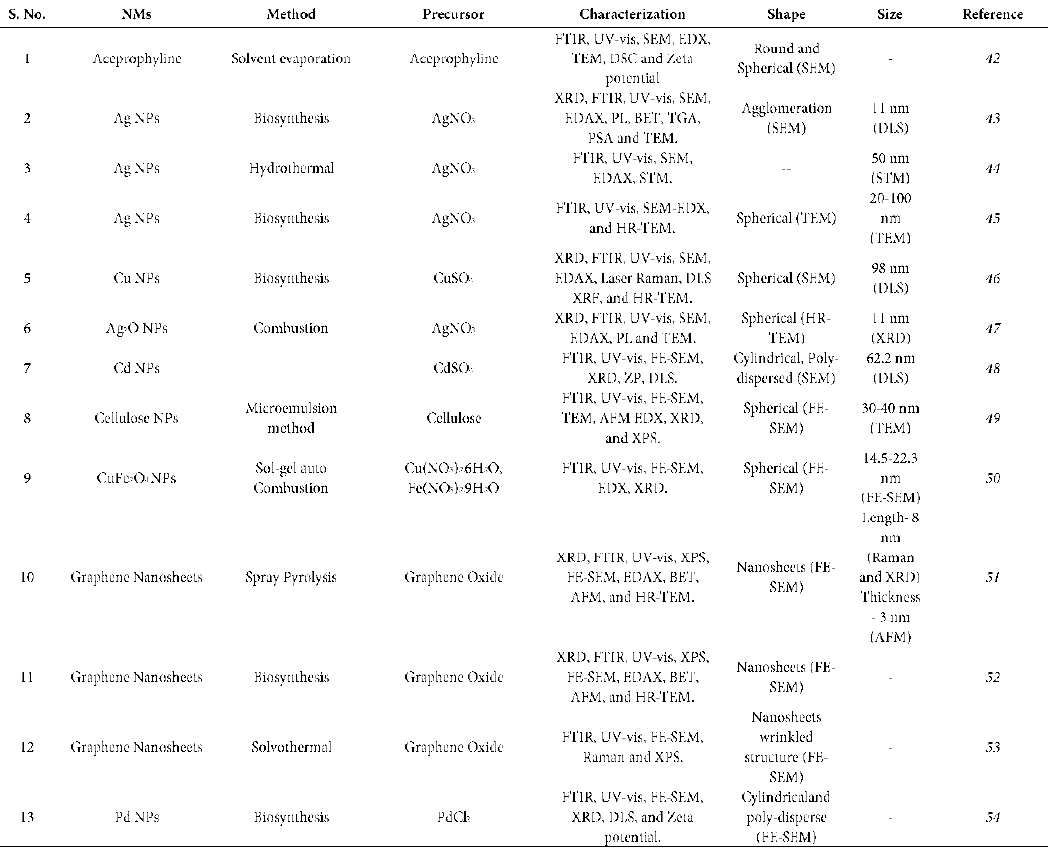
Table 1. Examples of cow urine mediated